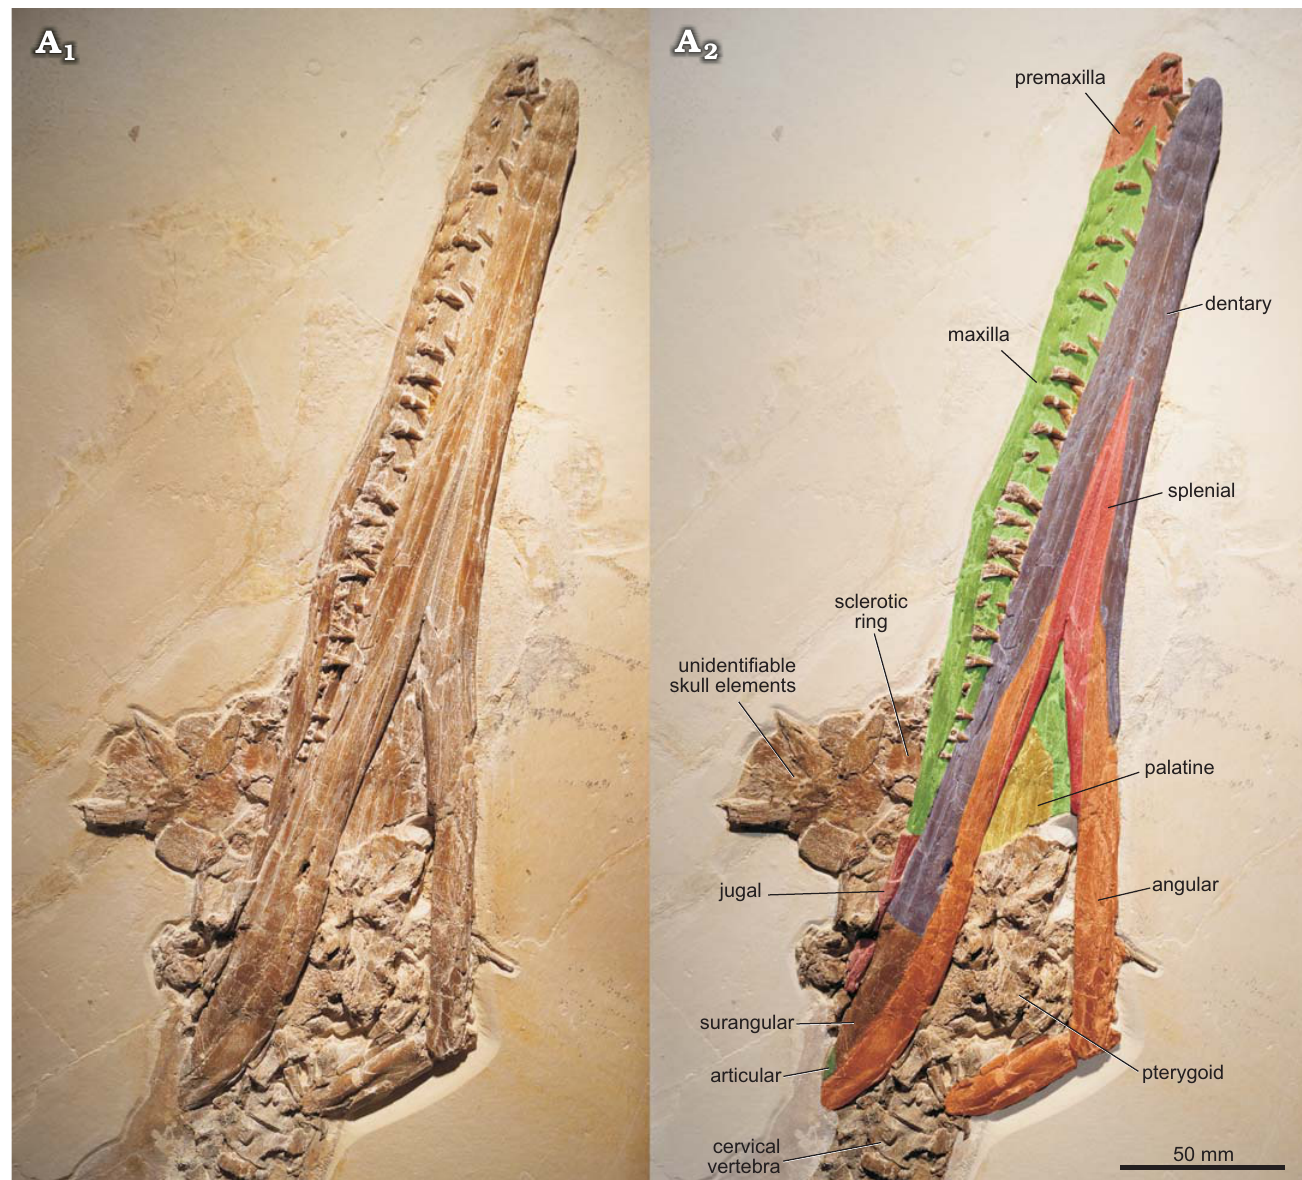
Fig. 3. Metriorhynchid thalattosuchian Cricosaurus bambergensis sp. nov. (NKMB-P-Watt14/274) holotype, late Kimmeridgian of Wattendorf (south- ern Germany). A 1 , skull in ventrolateral view; A 2 , illustrates the preserved elements which can be unambiguously identified (please note that the den- tary-surangular contact cannot be traced and is based upon the position in C. suevicus